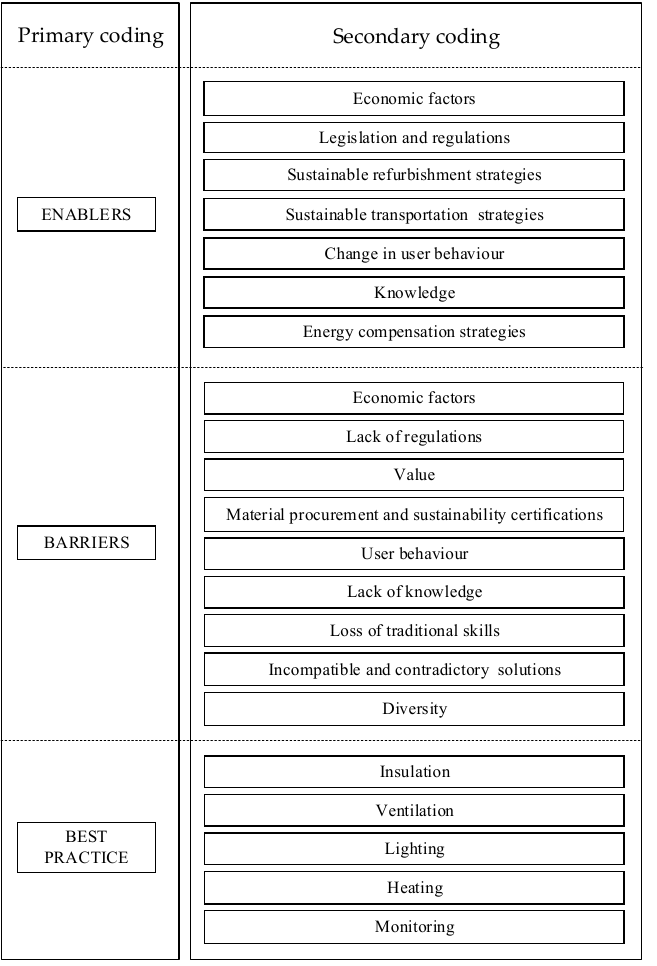
Figure 1. List of primary and secondary coding.